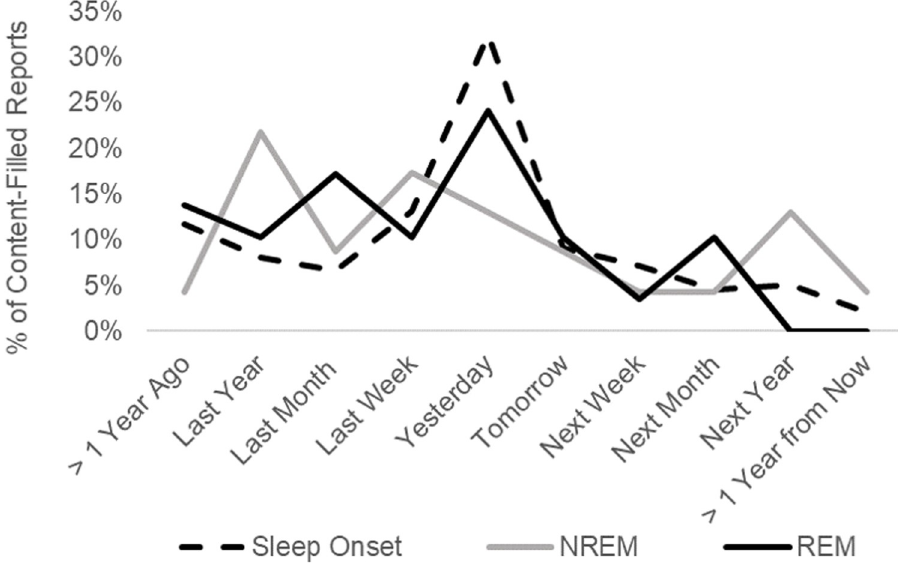
Fig 4. Past and future temporal references by sleep stage. Episodic sources by temporal origin and sleep stage. Percentages are relative to all content-filled reports with a valid source. NREM = Non-rapid eye movement sleep. REM = Rapid eye movement